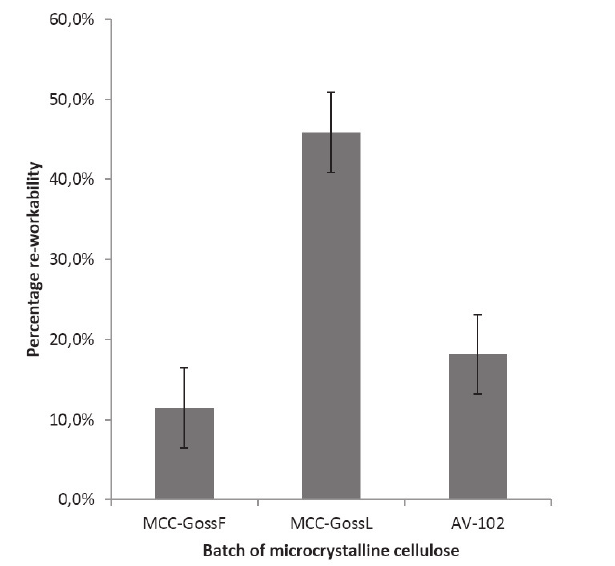
FIGURE 7 - Reworking potential of MCC-GossF, MCC- GossL and